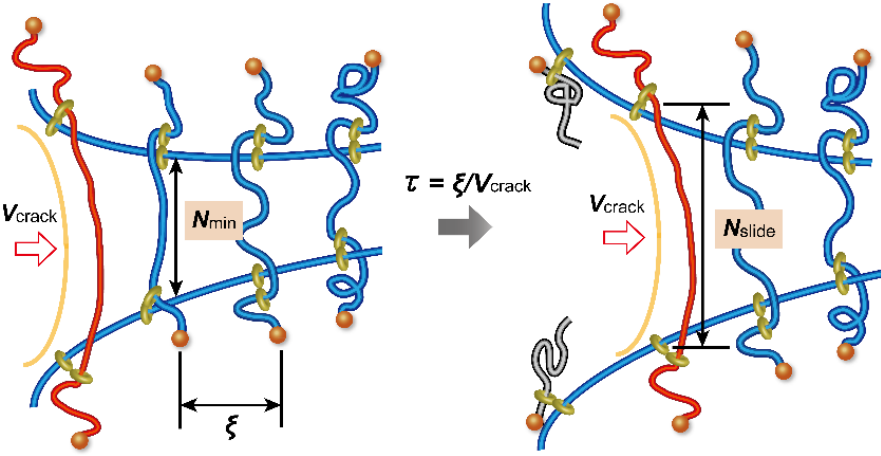
Figure 16. Schematic illustration of crack propagation model for SR gels. Reprinted from [31] with permission from Elsevier.